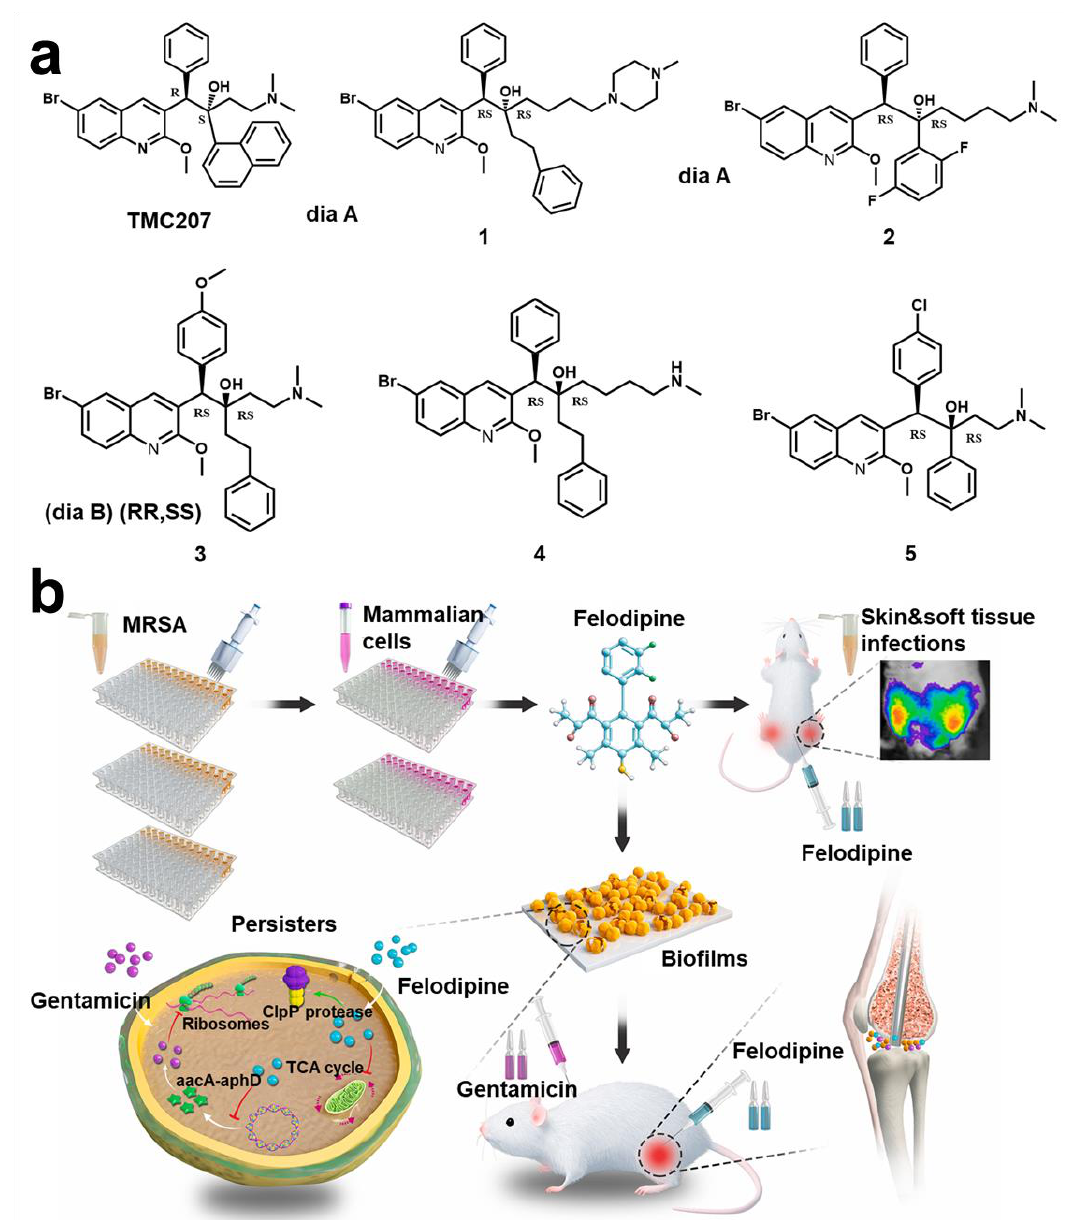
Figure 9. Persistent and dormant cells targeting technology. ( a ) Compound structure (TMC207) with the function of targeting persistent bacteria and related derivative structure (Compound 1–5 ). Reprinted with permission from Ref. [176]. Copyright 2012, Anil Koul. ( b ) New uses of old drugs sides on persistent cells. Reprinted from Ref. [185].